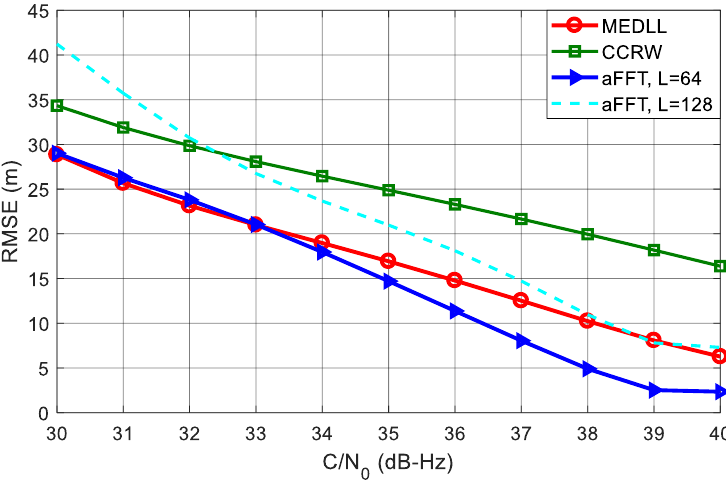
Figure 11. RMSE curves of averaging-FFT, MEDLL and CCRW methods with C/N 0 varying from 30 dB-Hz to 40 dB-Hz.